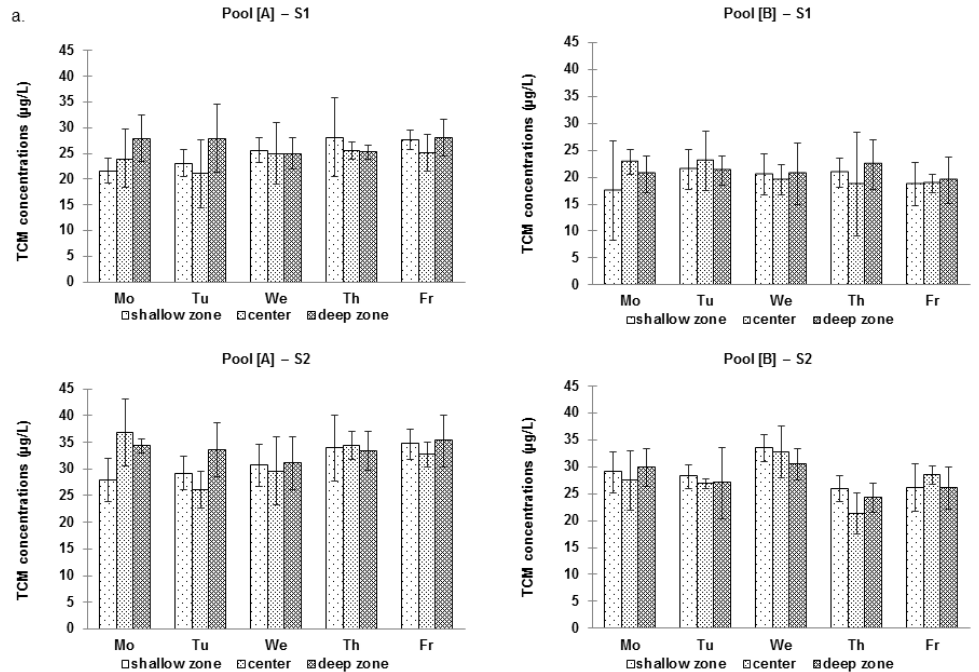
Figure 2. Mean DBP water concentrations (µg/L) in the various zones of pool [A] and [B] during session S1 and S2. ( a ) TCM; ( b )